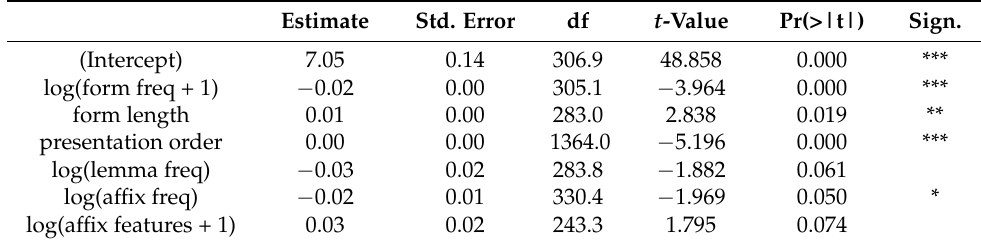
Table 6. Fixed effects of model with all six